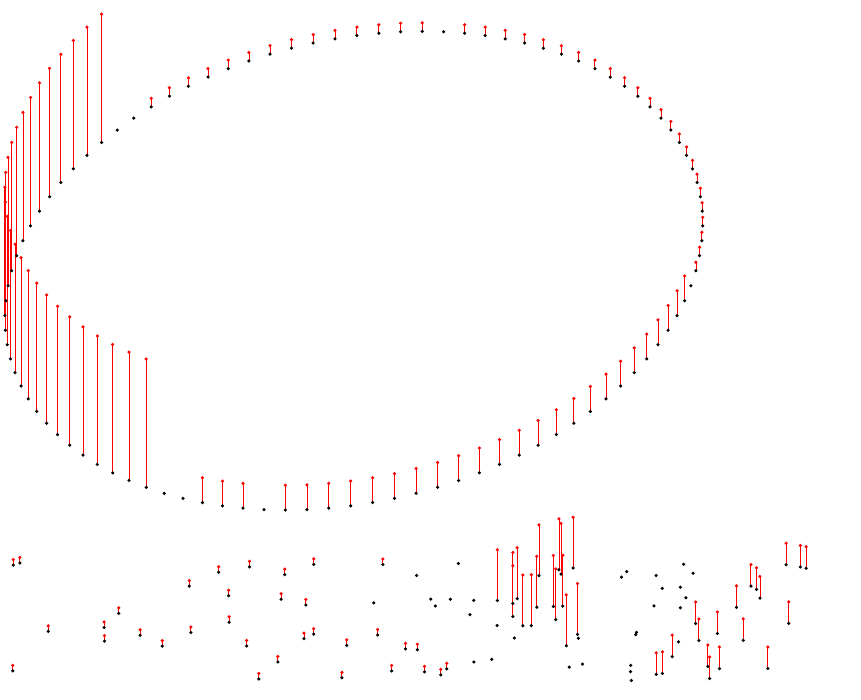
Figure 4. Local smoothness of the signals from Figure 3. The values are shown for nonzero signal samples. The local smoothness in classical signal analysis is related to the instantaneous frequency as λ ( n ) = 4sin 2 ( ω ( n ) /2 )